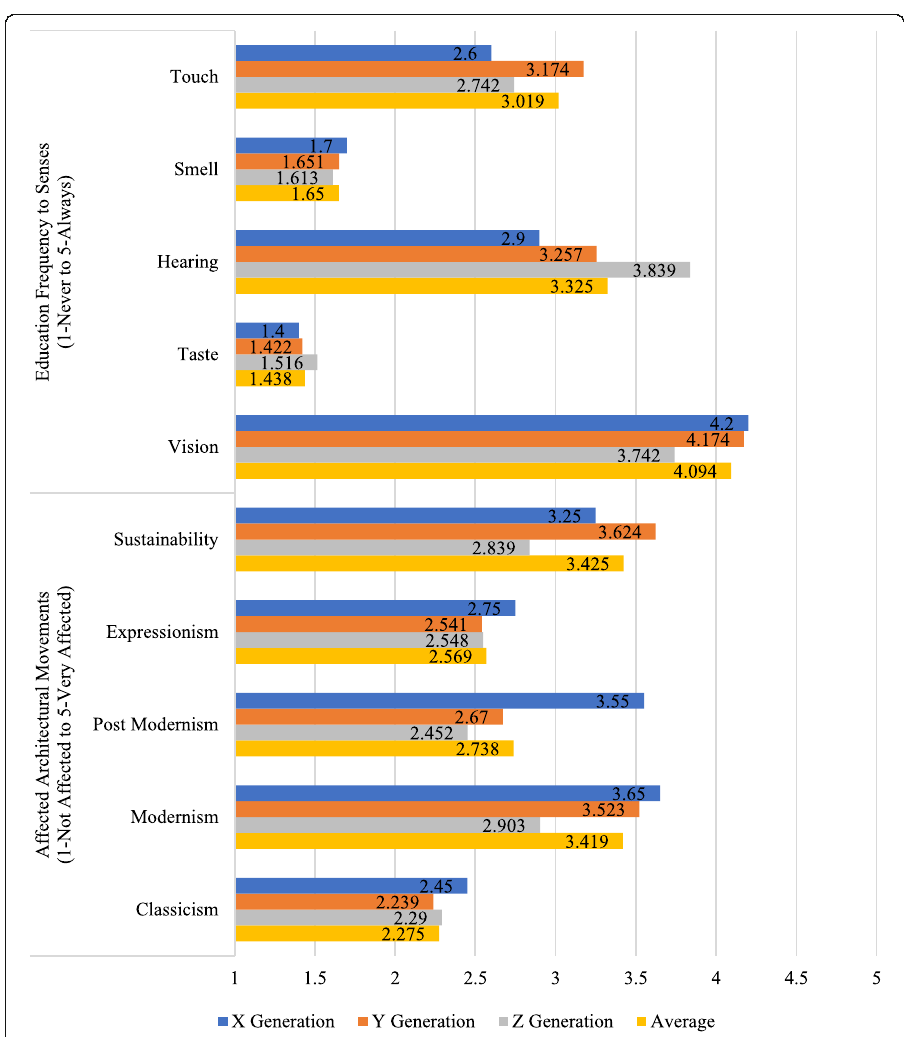
Fig. 2 Education Frequency to Senses and Affected Architectural Movements throughout the Education